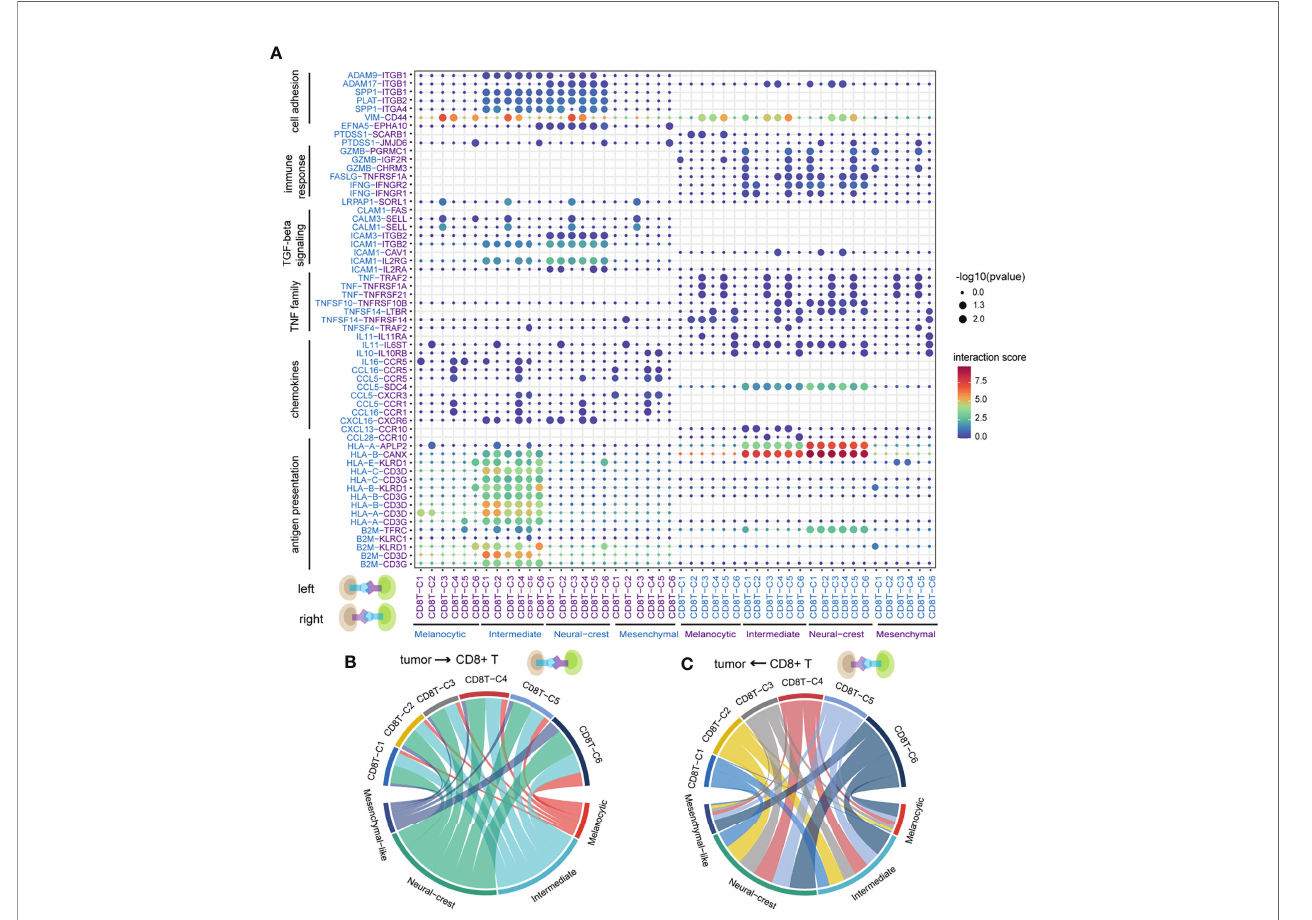
FIGURE 3 | The landscape of ligand – receptor interactions between tumor cells and CD8+ T cells. (A) Bubble heatmap showing the interaction strength for selected ligand – receptor pairs. Dot size indicates p -value generated by the permutation test and dot color represents interaction strength. (B) The number of signi fi cant ligand – receptor pairs between tumor cells and CD8+ T cells when tumor cells act as senders. Each link is colored by the tumor cell states and link thickness represents the number of signi fi cant ligand – receptor pairs. (C) The number of signi fi cant ligand – receptor pairs between tumor cells and CD8+ T cells when CD8+ T cells act as senders. Each link is colored by the CD8+ T-cell